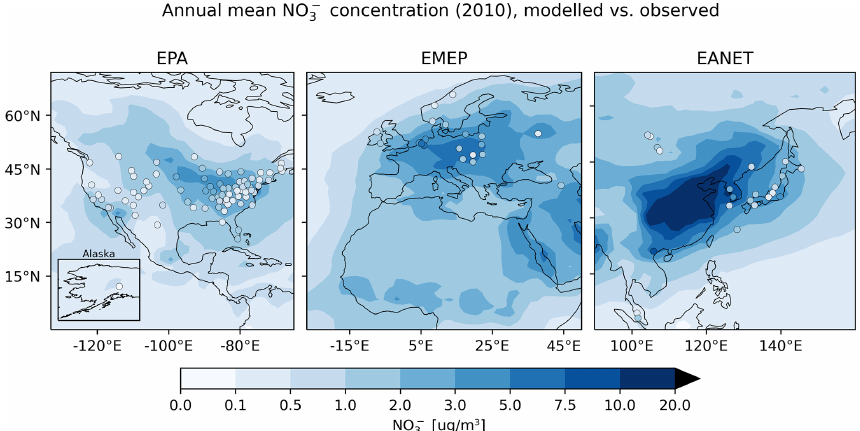
Figure 24. The same as Fig. 21 but for NO −